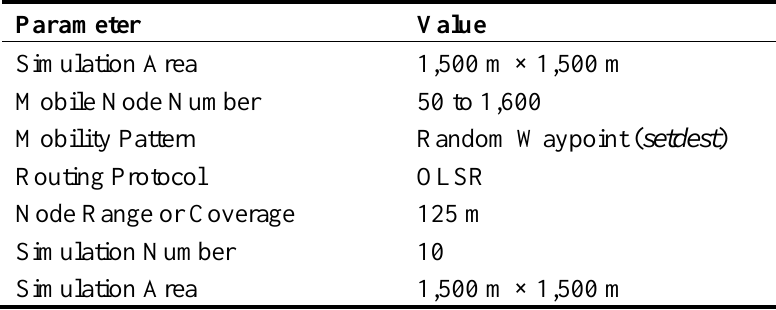
Table 1. Simulation